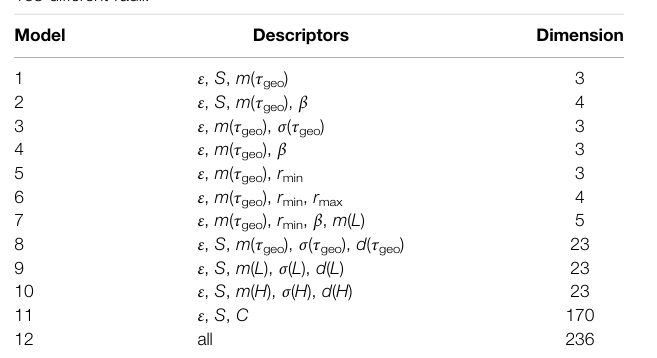
TABLE 3 | Descriptor sets used as input for the ANNs, together with the dimensions of the corresponding input vectors. Note that Models 8, 9 and 10 involve four scalar quanities and one distributional characteristic described by 19 quantiles, whereas the two-point correlation function in Model 1 is evaluated for 168 different radii.